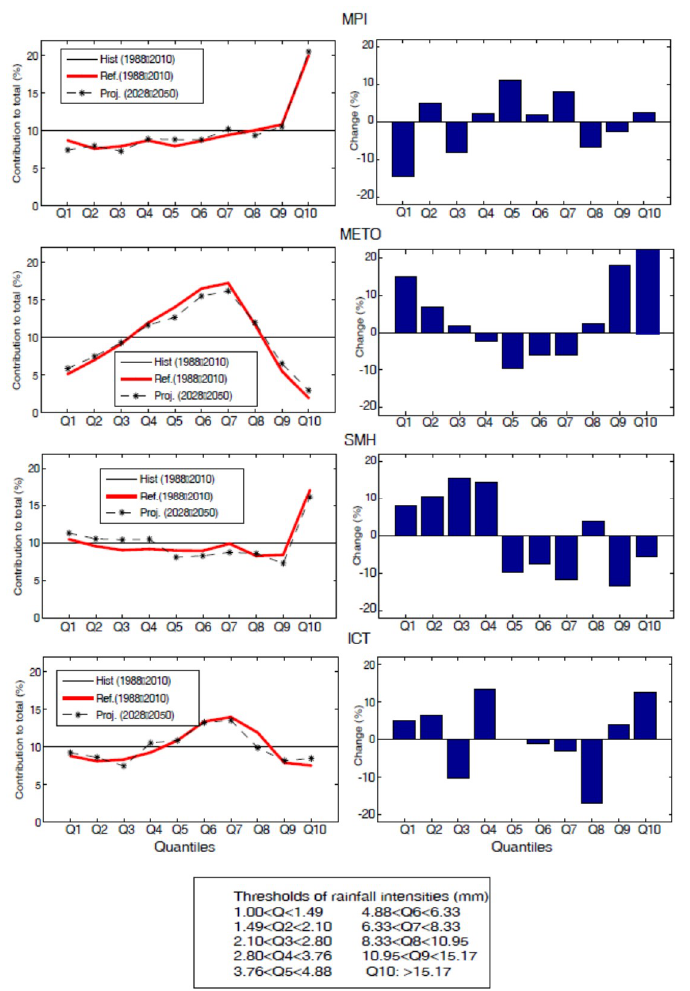
Figure 10. Comparison of the contribution of the 10 classes of quantile of daily precipitation defined from observations (interpolated rainfall field) to total precipitation under present-day and future climates (SRES-A1B scenario) (left), and changes between the reference and projection periods (right).